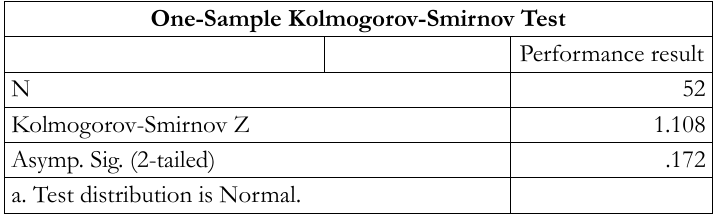
Table 8. The data normality test results